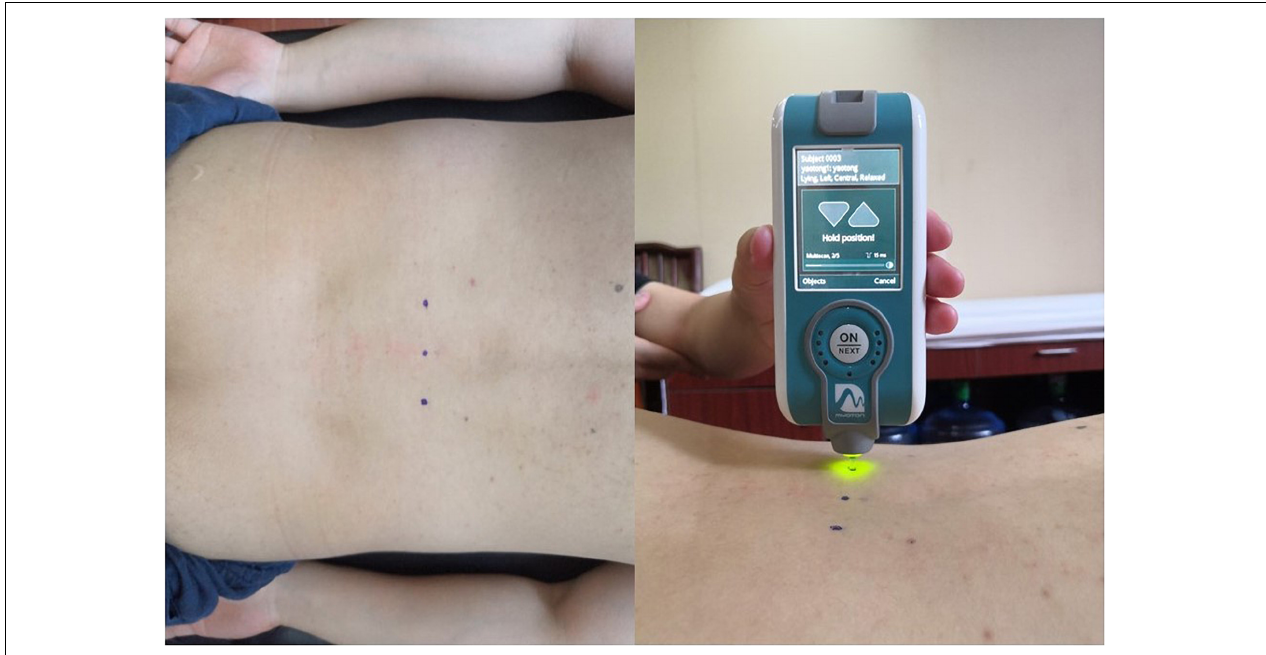
FIGURE 1 | Measurement points and MyotonPRO probe contact measurement points.